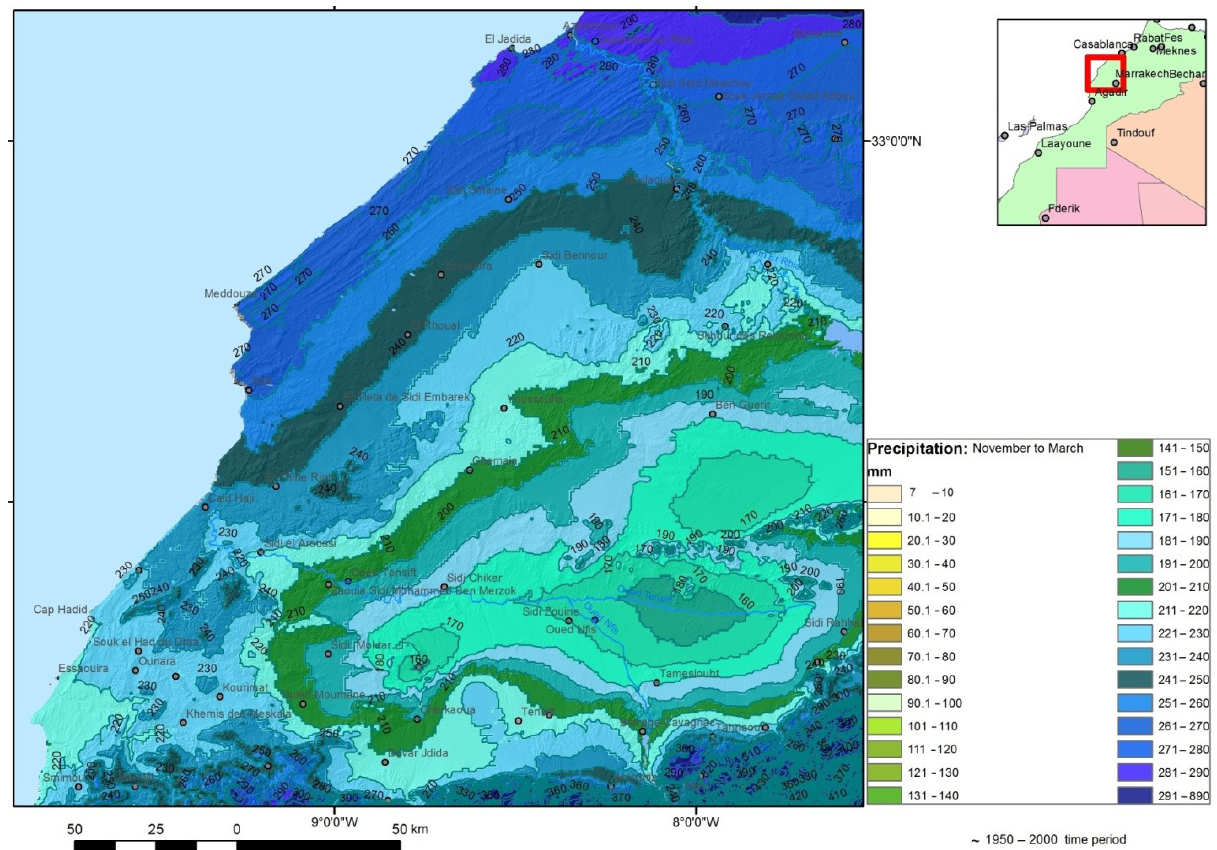
Figure 2. Mean precipitation (mm) during the time period from November to March (data: